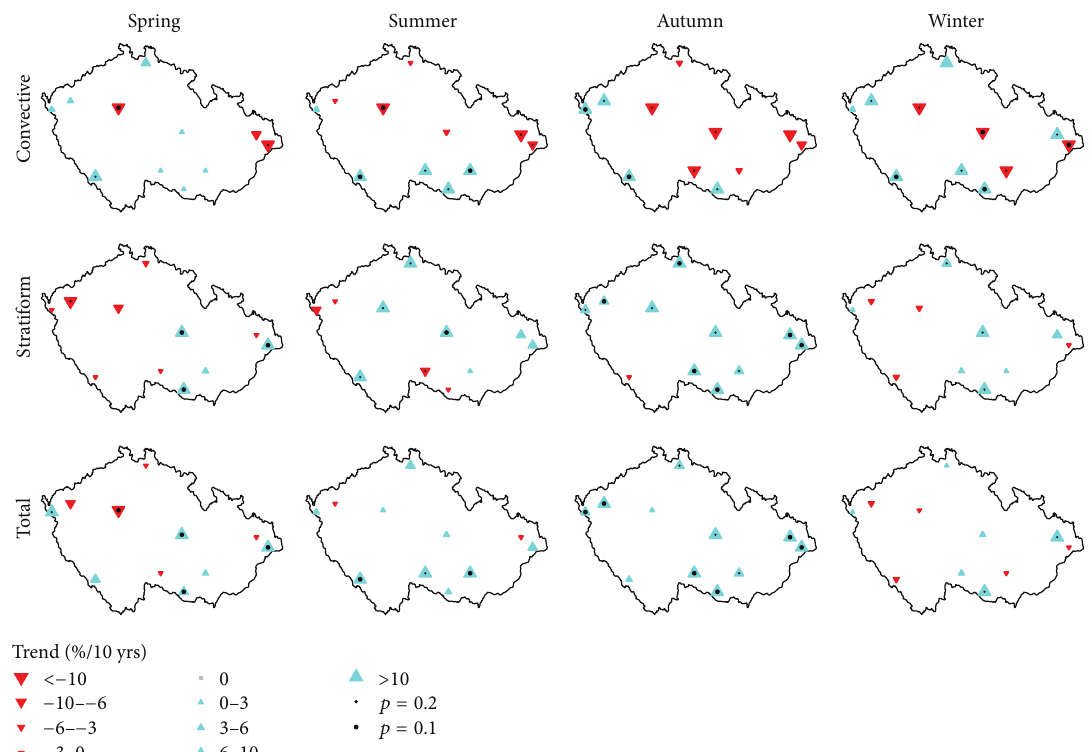
Figure 5: Same as in Figure 4 but for maximum seasonal 1-day precipitation amount